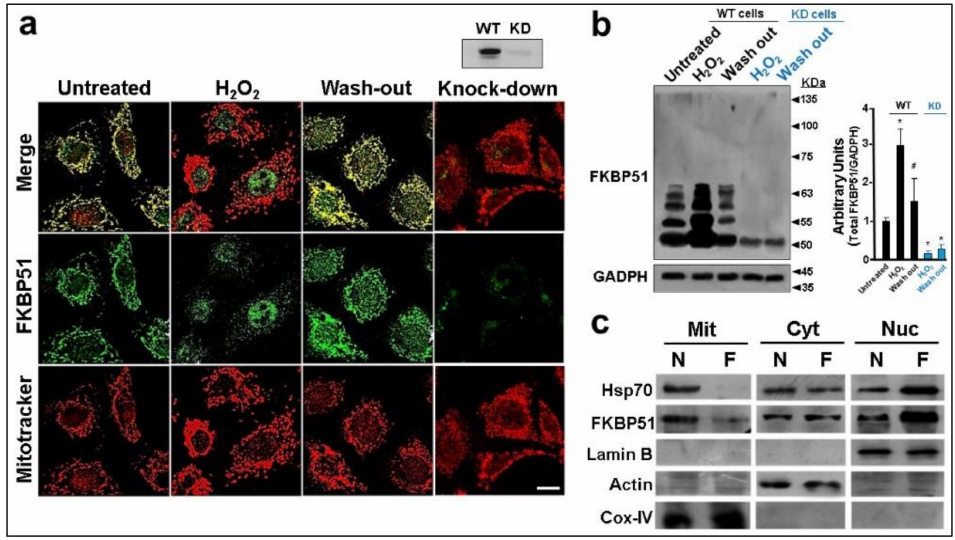
Figure 1. FKBP51 undergoes nuclear-mitochondrial shuttling. ( a ) Confocal microscopy of 3T3-L1 fibroblasts stained for the mitochondrial marker MitoTracker (red) and wild type (WT) FKBP51 (green). FKBP51 translocates to the nucleus after 20 min of cell exposure to 0.25 mM H 2 O 2 , and fully cycles back to mitochondria after 30 min the peroxide was washed out. The knock-down (KD) of FKBP51 fully abolishes the signal (Western blot shown on the top of the column). White bar = 10 um. ( b ) Western blots for endogenous FKBP51 were performed in lysates from untreated cells, after 1 h of cell exposure to H 2 O 2 , or 1 h after the peroxide was washed out. Blue labels correspond to cells treated with siRNA against FKBP51 (KD). The plot shows a semi-quantification of the bands by densitometry (* different from untreated cells at p < 0.005; # wash out WT cells versus peroxide-treated WT cells, different at p < 0.010). ( c ) Biochemical fractionation into mitochondria (Mit), cytosol (Cyt), and nuclei (Nuc) of liver extracts from normally fed mice (N) and mice fasted overnight (F). Cox-IV, actin, and lamin B were used as markers of each respective subcellular